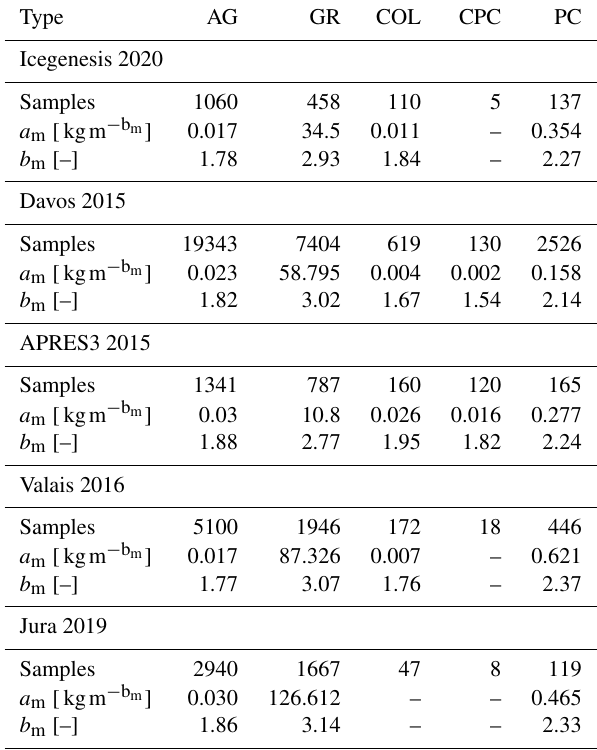
Table 5. Values of the parameters of the relation m = a m D b m max es- timated on the datasets of different field campaigns for various hy- drometeor types. m is estimated with GAN-3D, while the hydrome- teor type is obtained with the method by Praz et al. (2017). D max is the maximum dimension obtained from the triplet of images of the